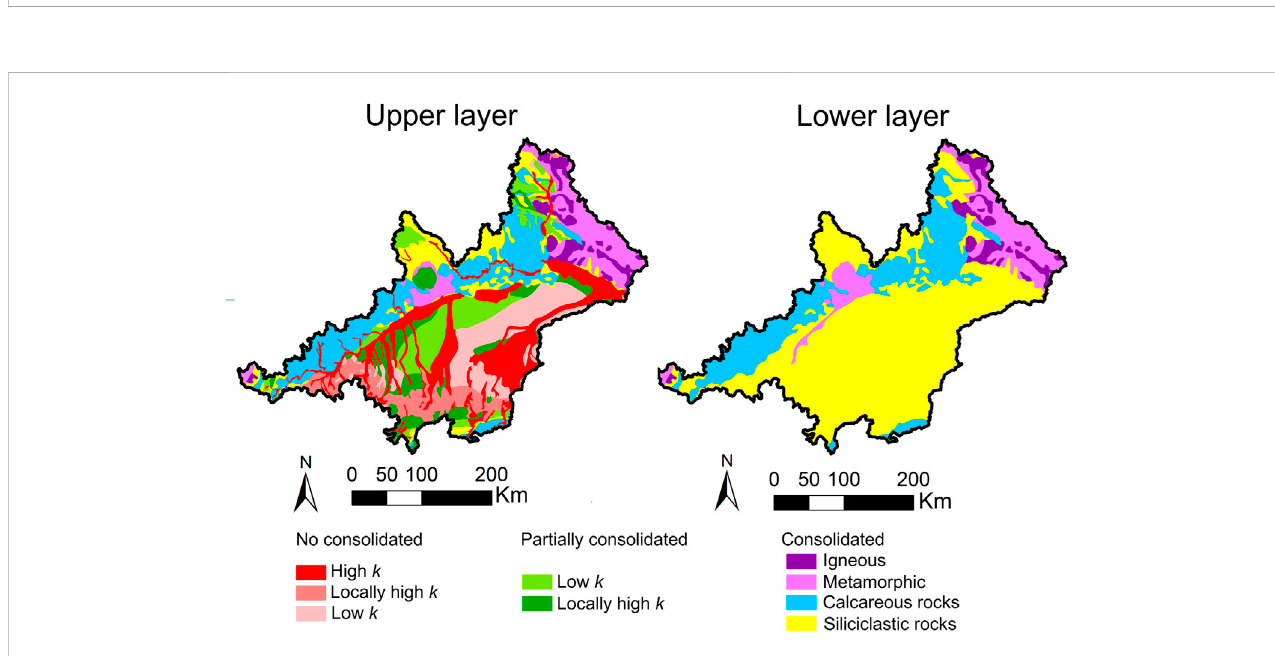
FIGURE 4 Areal distribution for parameterization considered for the two layers of the groundwater numerical